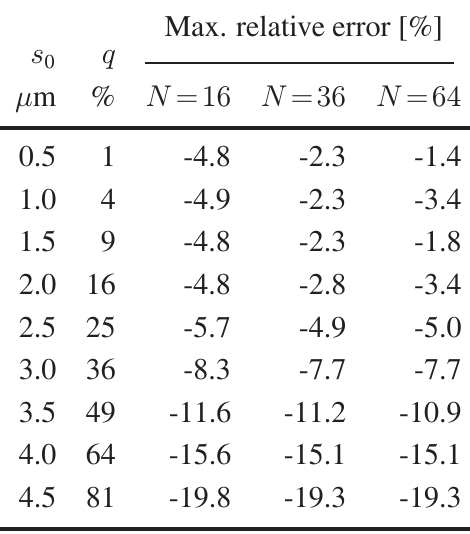
simulated with the m = 0 . 5 µ m . . . 5 µ m. Comparison is c